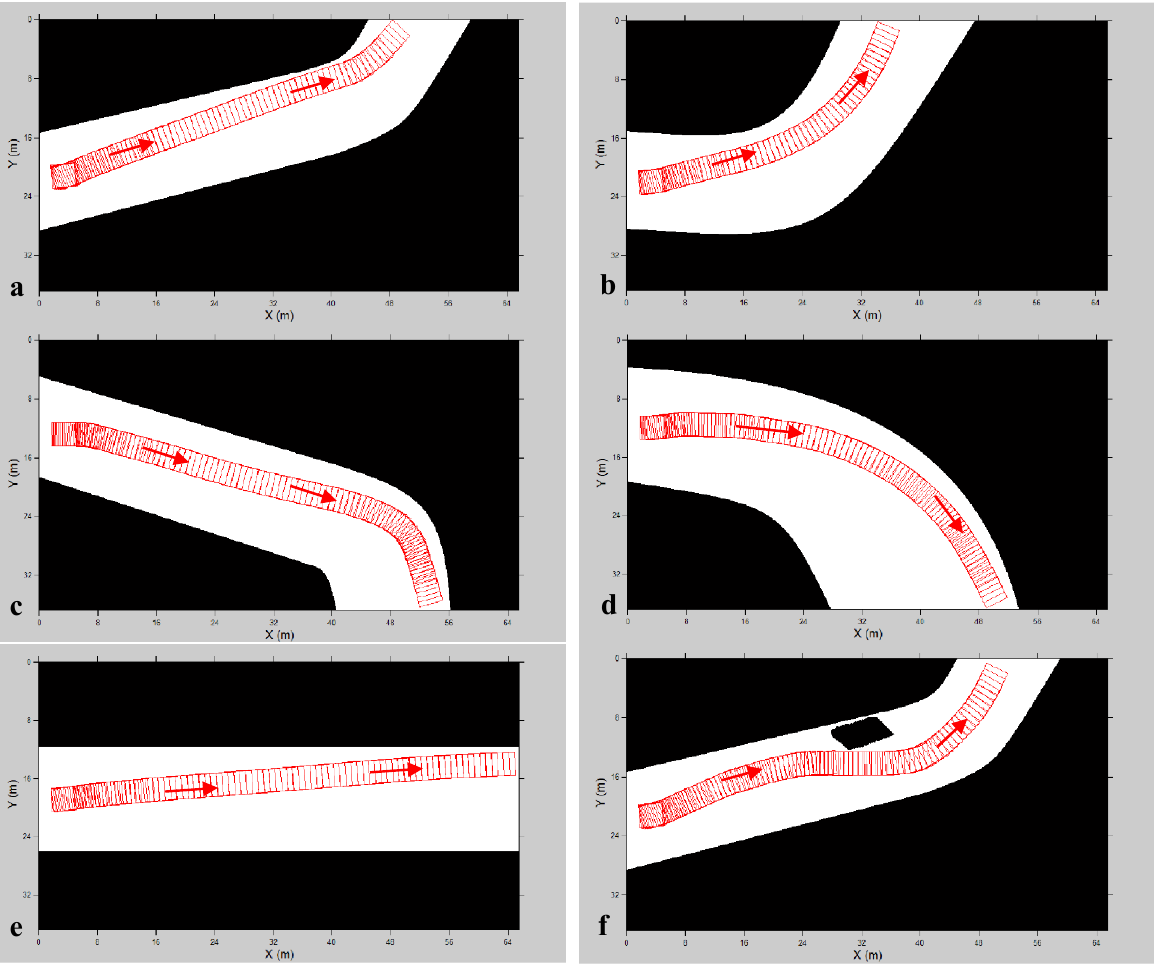
Figure 10. Simulation results with one vehicle. ( a ) First Left Turn Scenario; ( b ) Second Left Turn Scenario; ( c ) First Right Turn Scenario; ( d ) Second Right Turn Scenario; ( e ) Straight Road Scenario; ( f ) Obstacle Avoidance